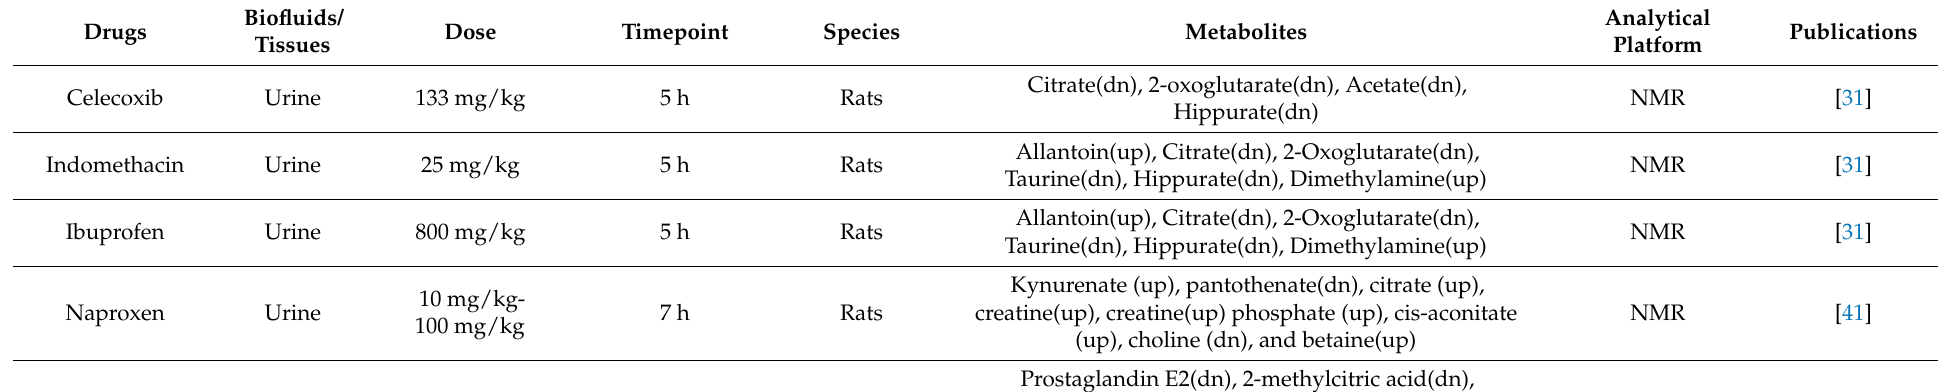
Table 1. List of the metabolites that are altered due to NSAIDs administration in rats as obtained from metabolomics studies. (up and dn denote upregulated and downregulated respectively, nm denote not mentioned in